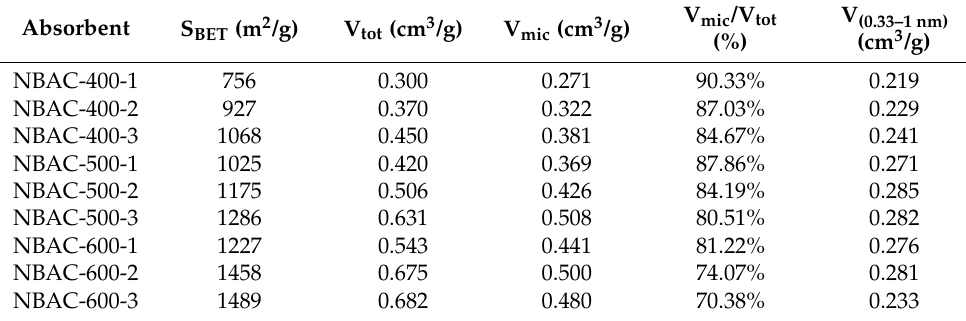
Table 1. Pore parameters of NBACs synthesized from N-doping activation.